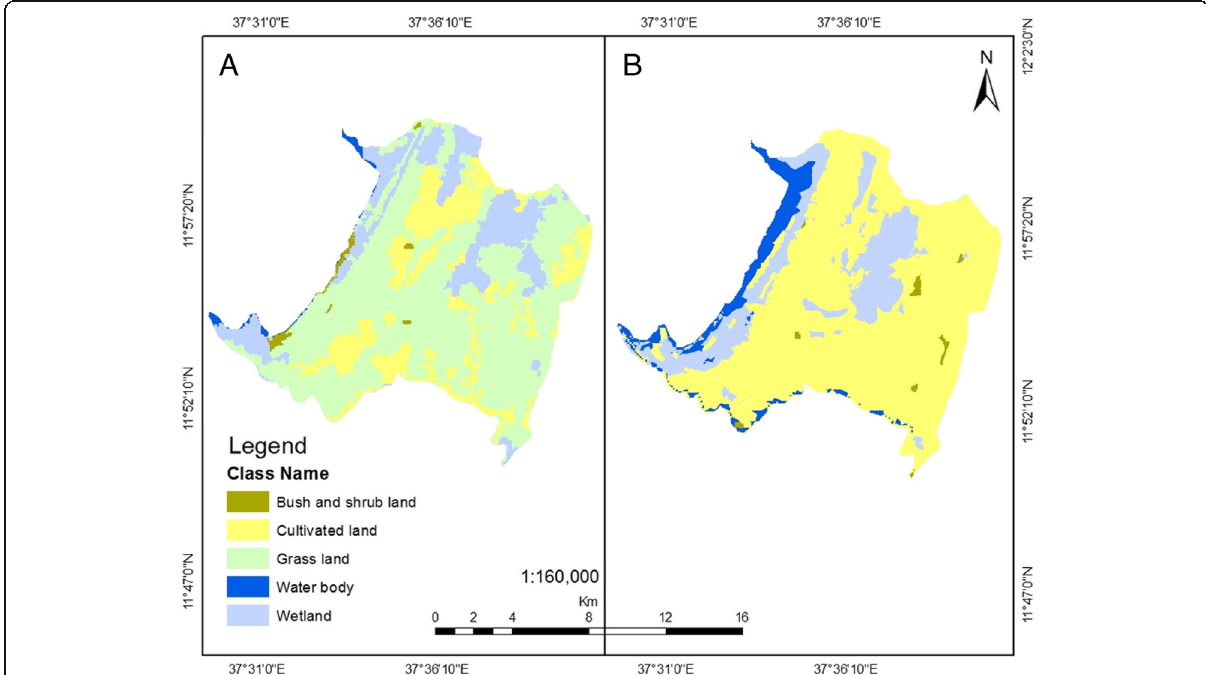
Fig. 7 Land use/land cover map of the study site. a , b The land use/land cover map of year 1973 and 2014, respectively. The classification results